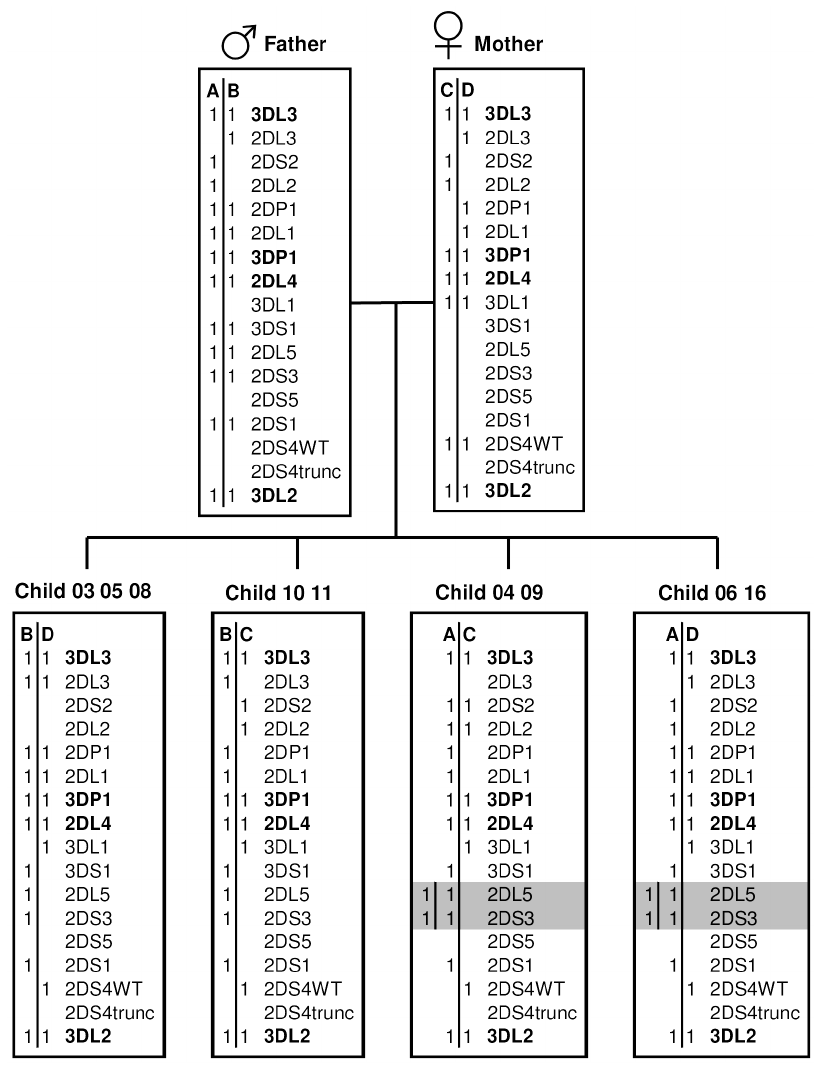
Figure 4. KIR gene pedigree analysis of a Centre d’Etude du Polymorphisme Humaine family by KIR-MLPA. Children 04, 06, 09 and 16 of family 1347 show a translocation event involving KIR2DL5 and KIR2DS3